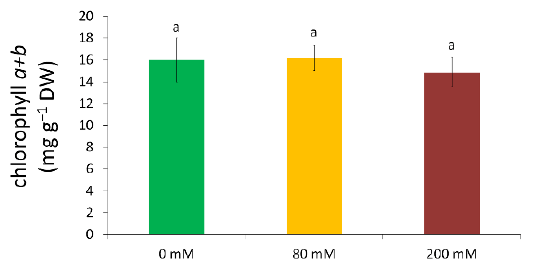
Figure 4. Total chlorophyll content of Arundo donax leaves expressed on a dry weight (DW) basis. Error bars represent SD values. To compare the differences, one-way ANOVA was performed with Tukey’s post-hoc test on the treatments ( p < 0.05). Same lowercase letters indicate there are no significantly different groups.